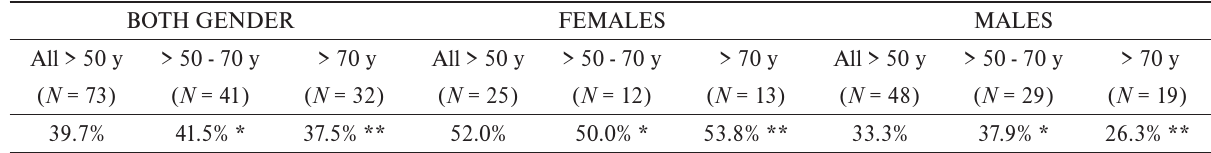
Table 4. Prevalence of T -score ≤ -2.5 SD in the area of the proximal femur and/or at the lumbar spine in the age group over 50